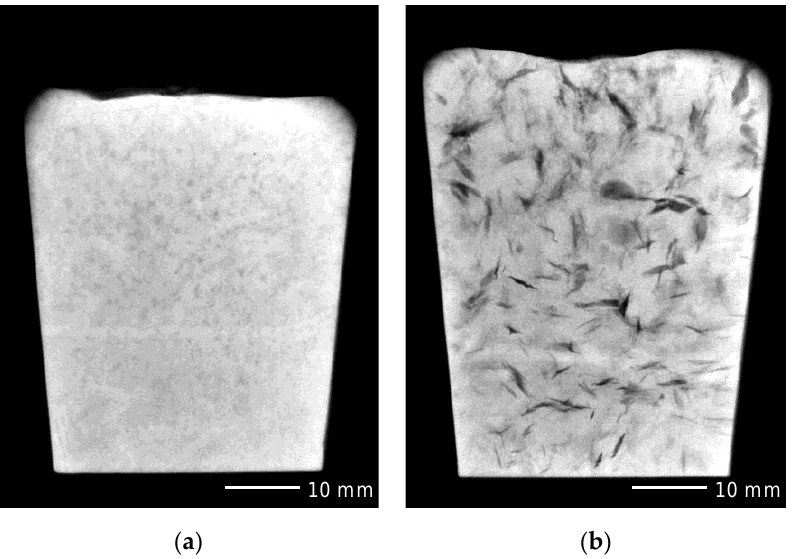
Figure 4. ( a ) Aluminium alloy frozen in air; ( b ) identical alloy frozen under 0.1 atm pressure Reprinted with permission from ref. [11]. Copyright 2022 Elsevier.